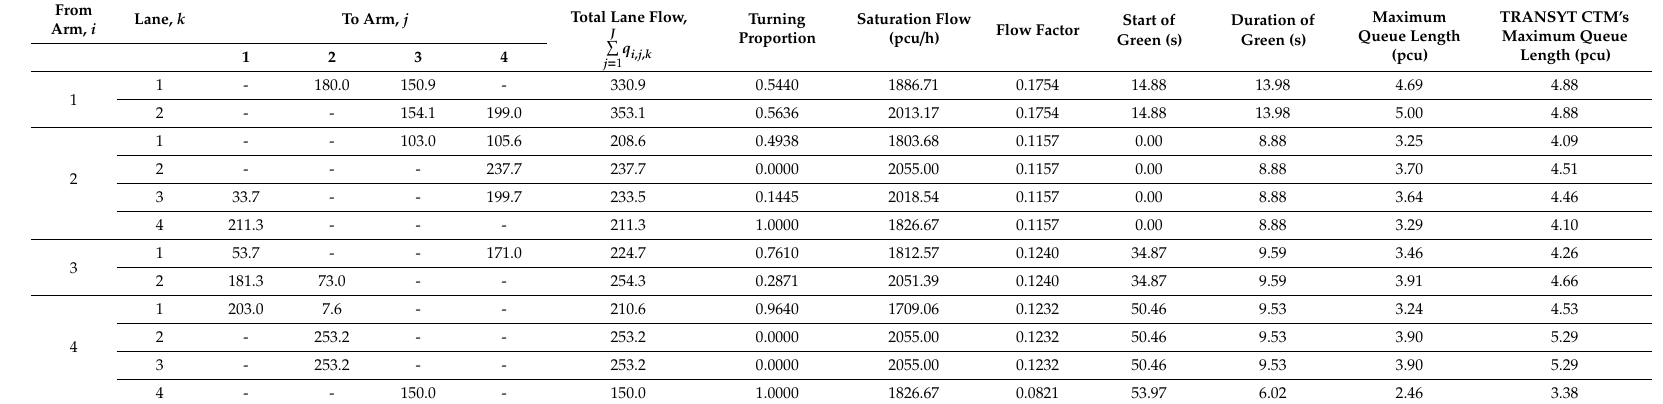
Table 2. Details of optimization results in the morning-peak period with cycle time = 65.99 s and common flow multiplier µ = 1.295. From Arm, i